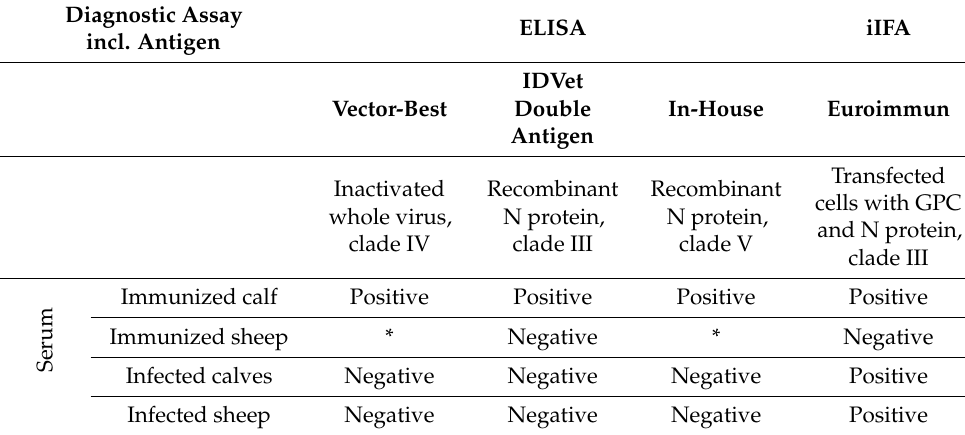
Table 3. Results obtained with CCHFV assays and NSDV